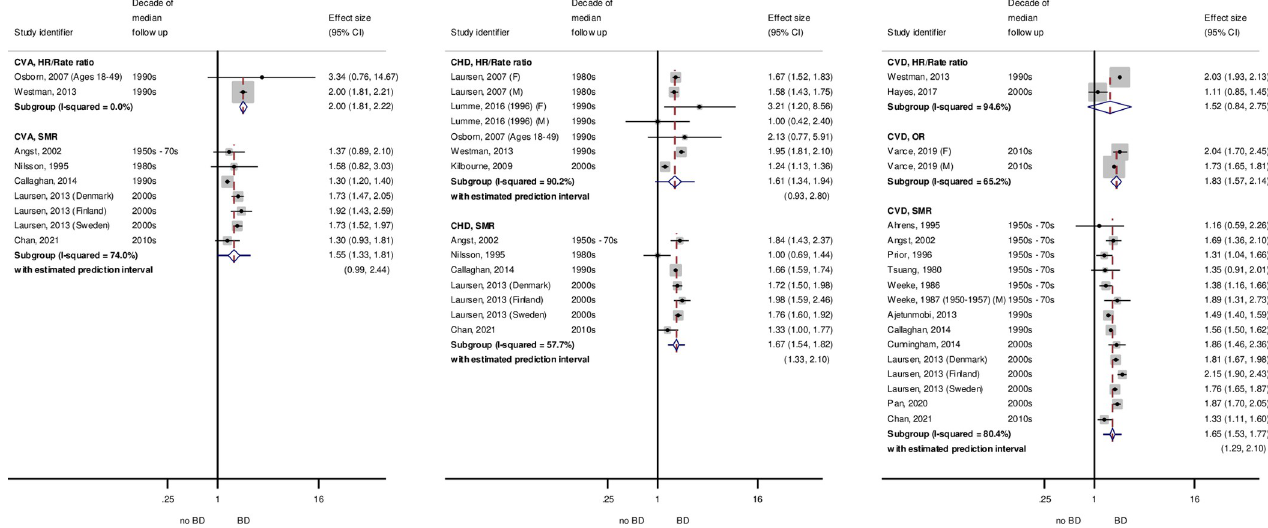
Fig 3. Forest plots showing relative risk of CVD mortality in those with versus without BD, studies included in meta-analysis. Weights are from random effects model. Dashed lines show pooled estimated risks within subgroups. Studies were allocated to decades according to the median year of follow-up. BD, bipolar disorder; CHD, coronary heart disease; CVA, cerebrovascular accident; CVD, all circulatory disease; F, female; HR, hazard ratio; M, male; OR, odds ratio; SMR, standardised mortality ratio.